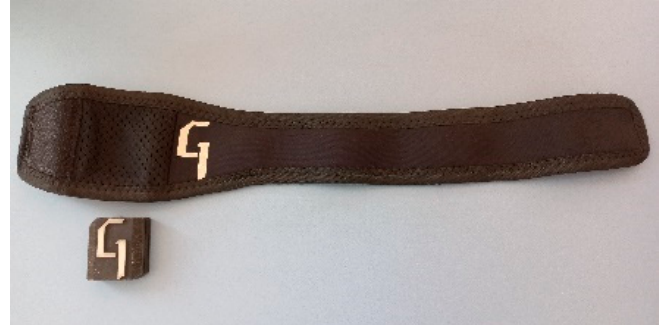
Figure 1. Hawk Figure 1. Hawk goniometer.